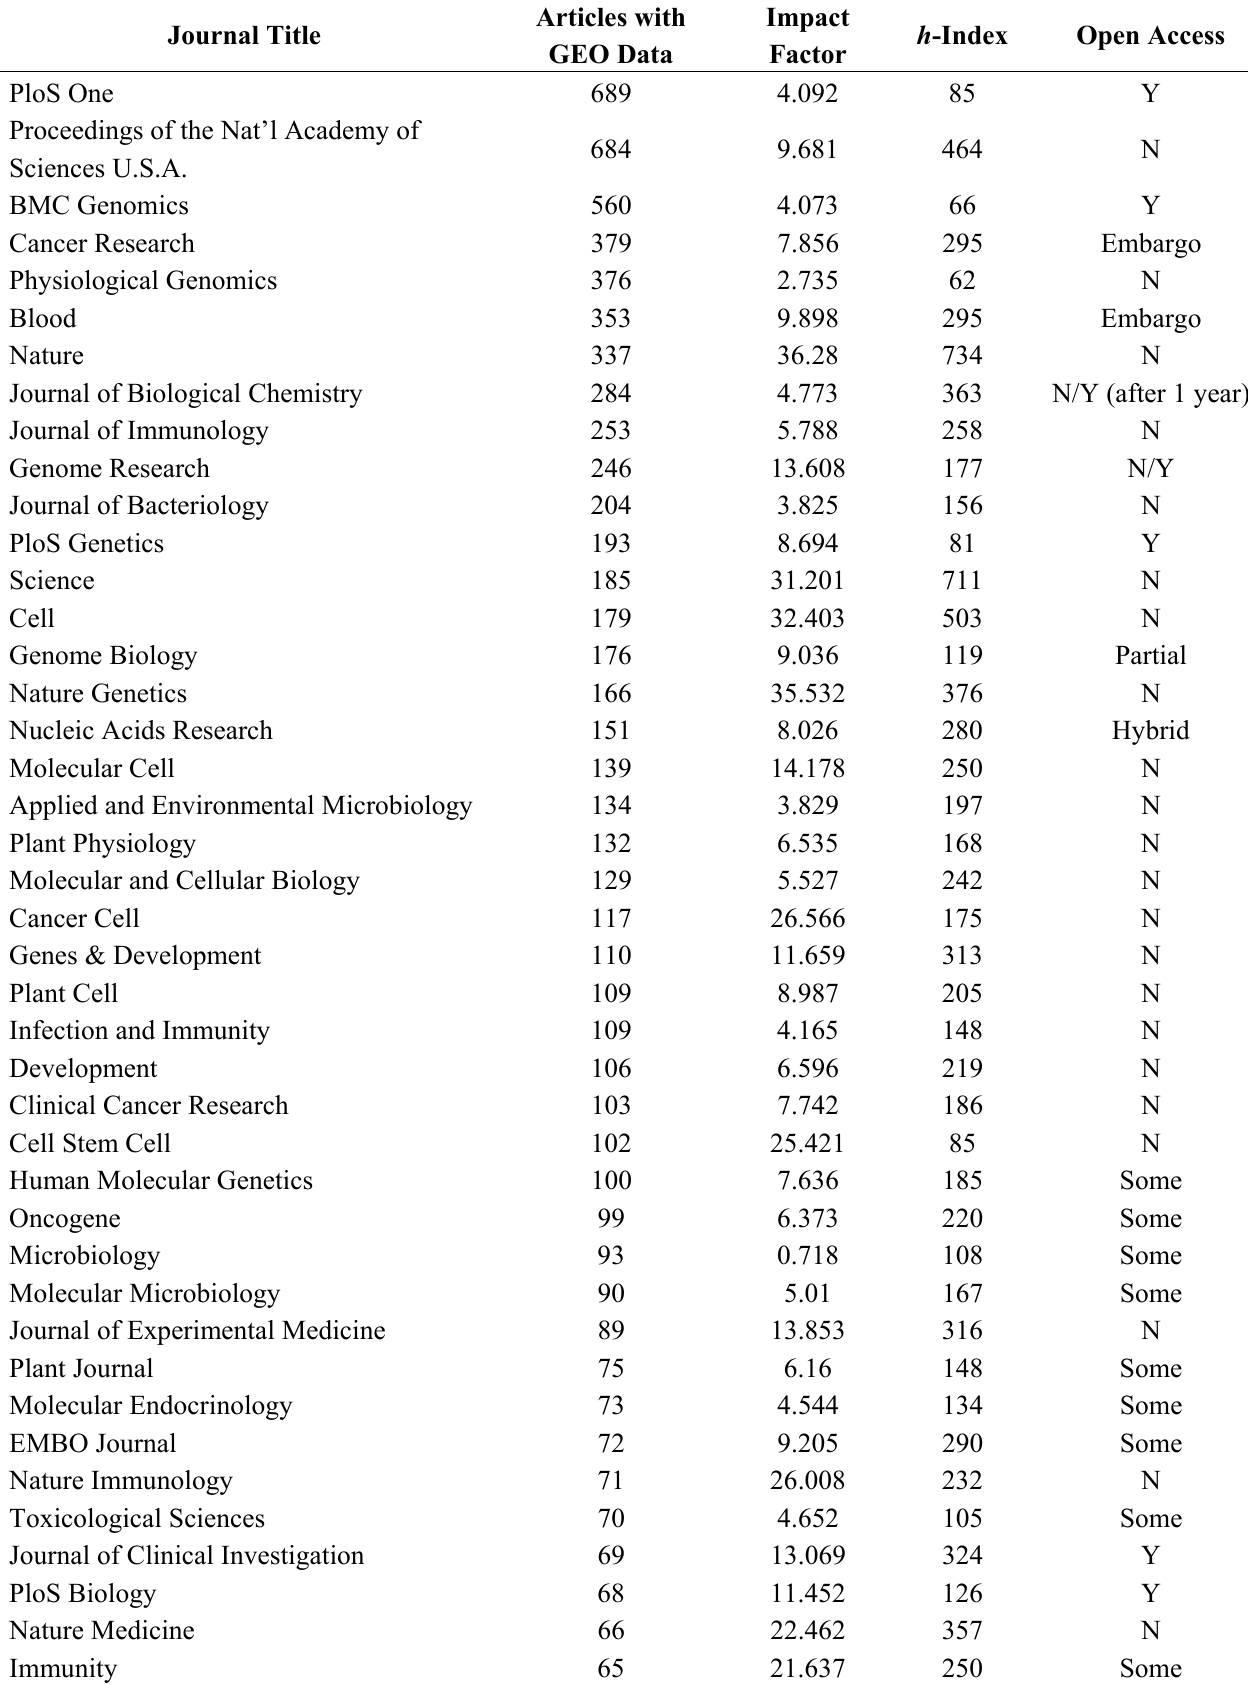
Table 3. Data contributions and journal reputation rankings by impact factor and h